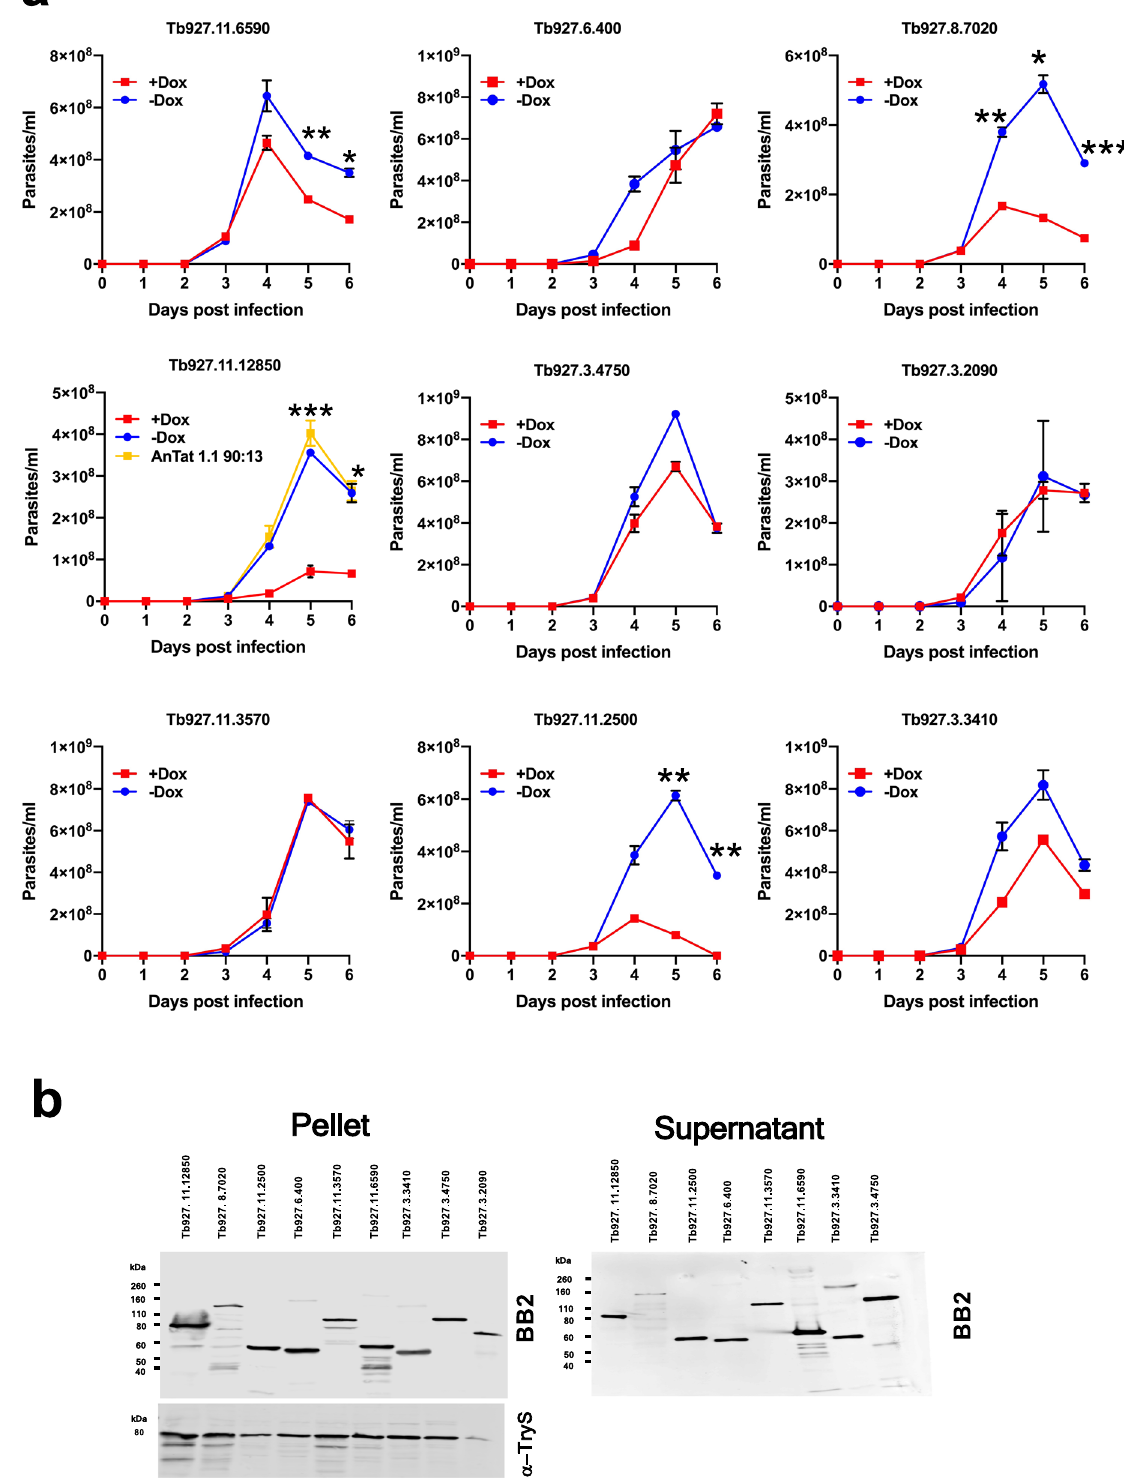
wild type cells (Supplementary Fig. 3) and for six peptidases, including Tb927.8.7020, the progression of the parasitaemia in mice was equivalent to parental cells, although Tb927.11.6590 slightly elevated the overall parasitaemia (Fig. 5b and Supplementary Fig. 4). This indicated their individual deletion did not strongly affect the fi tness or the developmental progression of the parasites in vivo. In contrast, null mutants for